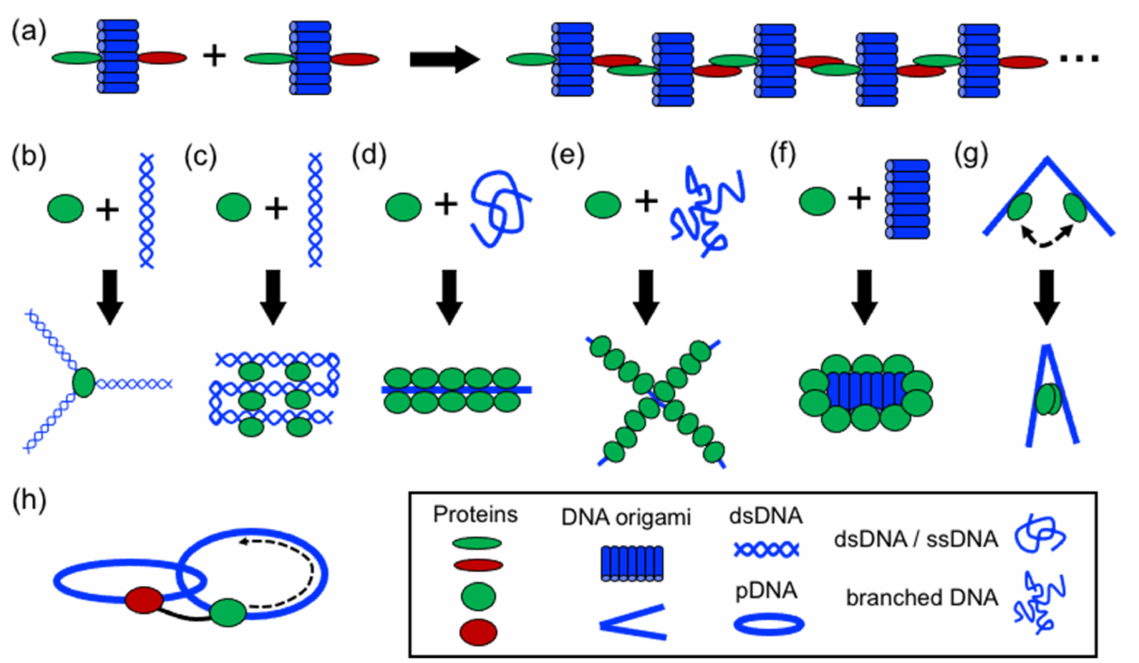
Figure 3. Strategies in structural protein–DNA nanotechnology. ( a ) Polymerizing; ( b ) directing spatial organization; ( c ) shaping DNA through bending and folding; ( d ) protein self-assembly on DNA; ( e , f ) coating and rigidizing DNA; ( g ) switching and ( h ) moving DNA components. DNA origami, ssDNA, and dsDNA molecules are depicted in blue; proteins are depicted in green and